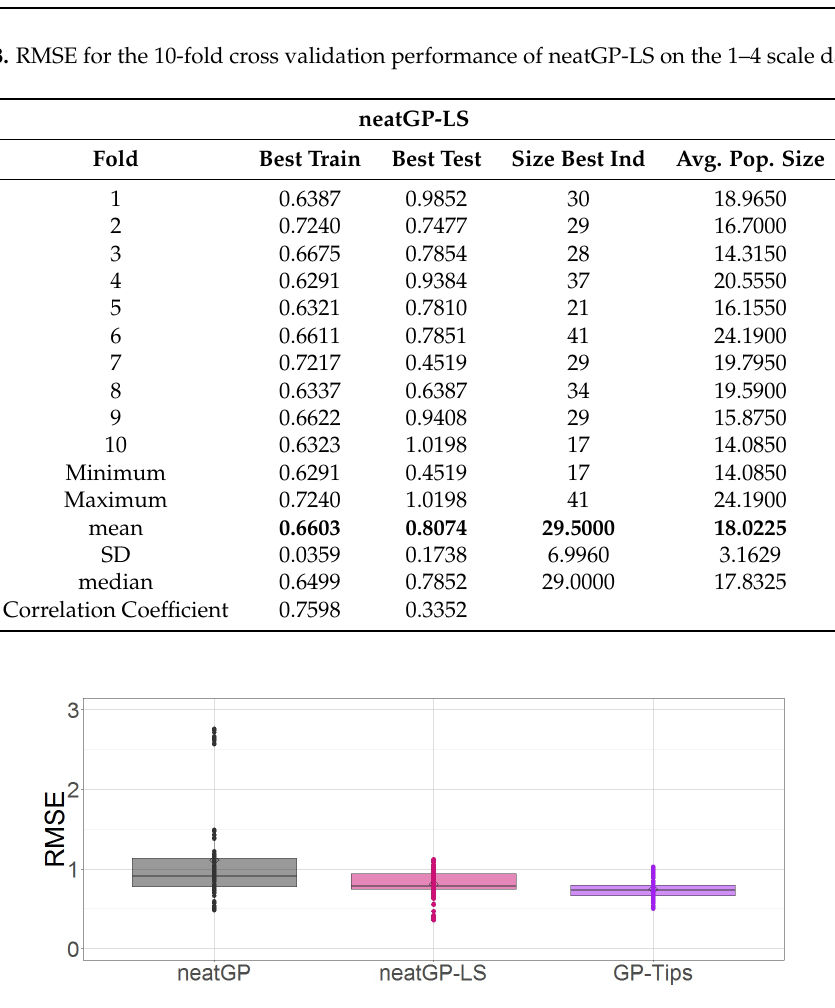
Figure 3. Box plot comparison of all methods based on testing fitness on the dataset with a 1–4